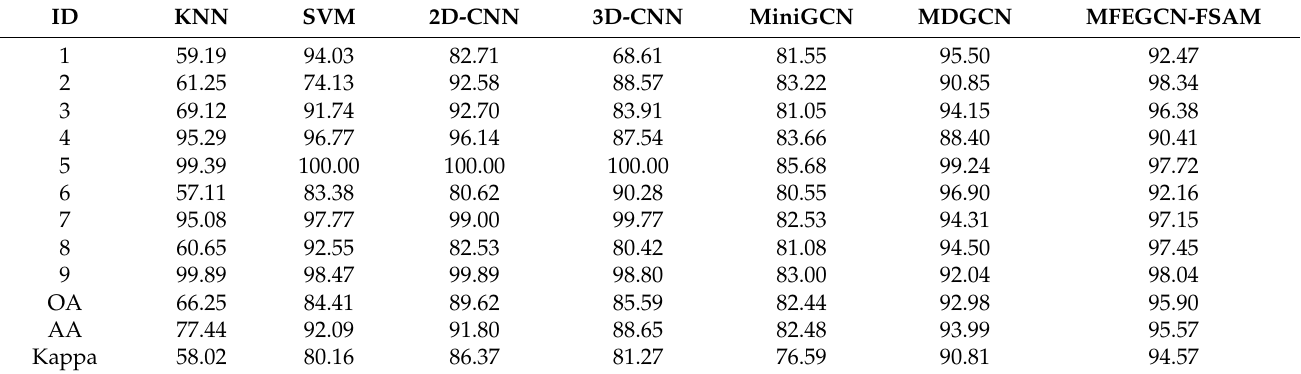
Table 6. Classification performance of different methods on the University of Pavia dataset